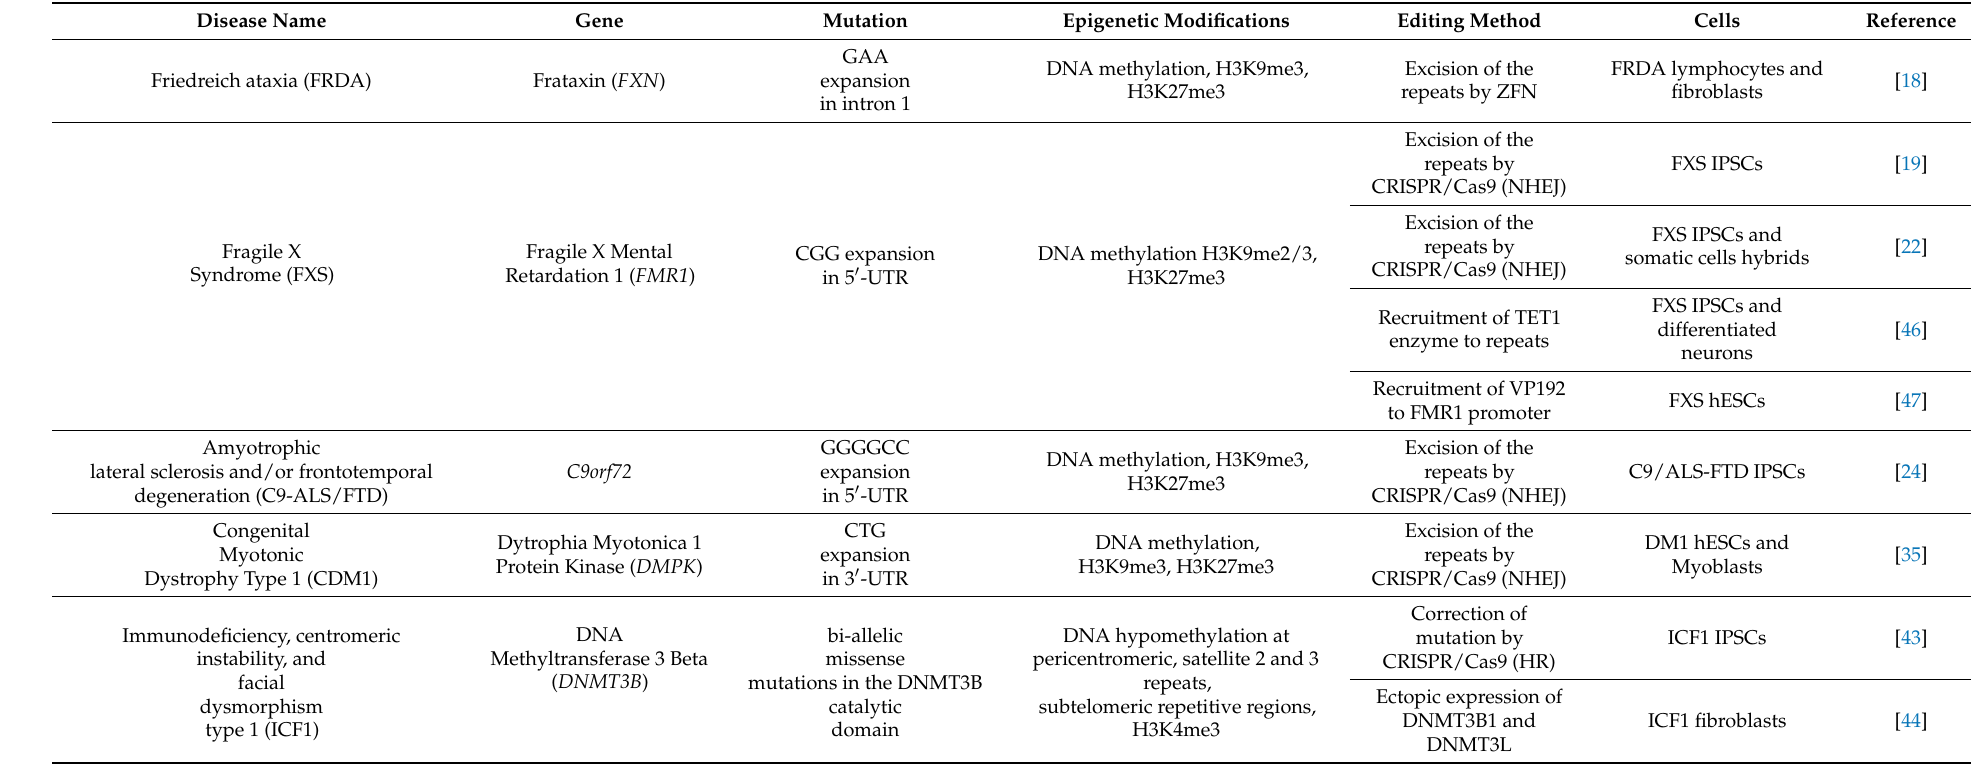
Table 1. Current studies on correction of secondary epimutations in repeat associated